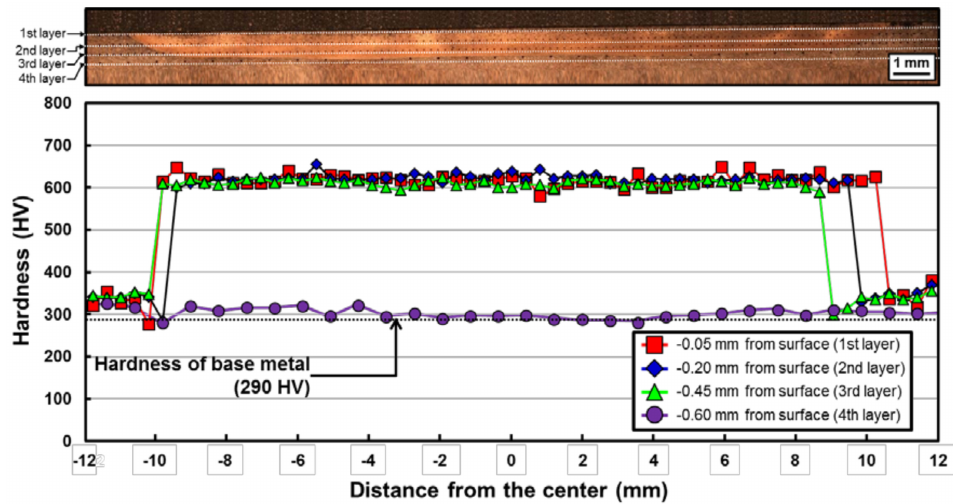
Figure 8. Hardness distribution and corresponding macrostructure of the heat-treated cross-sectional specimen at temperatures of 1473 K for P20-improved steel.